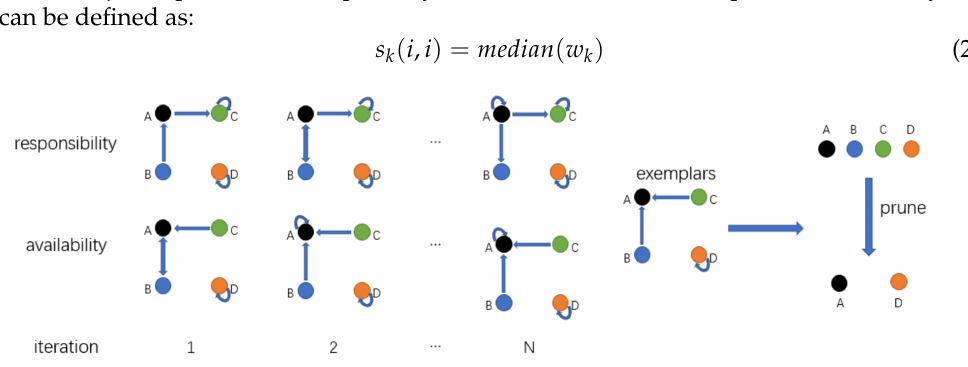
Figure 3. Schematic diagram of